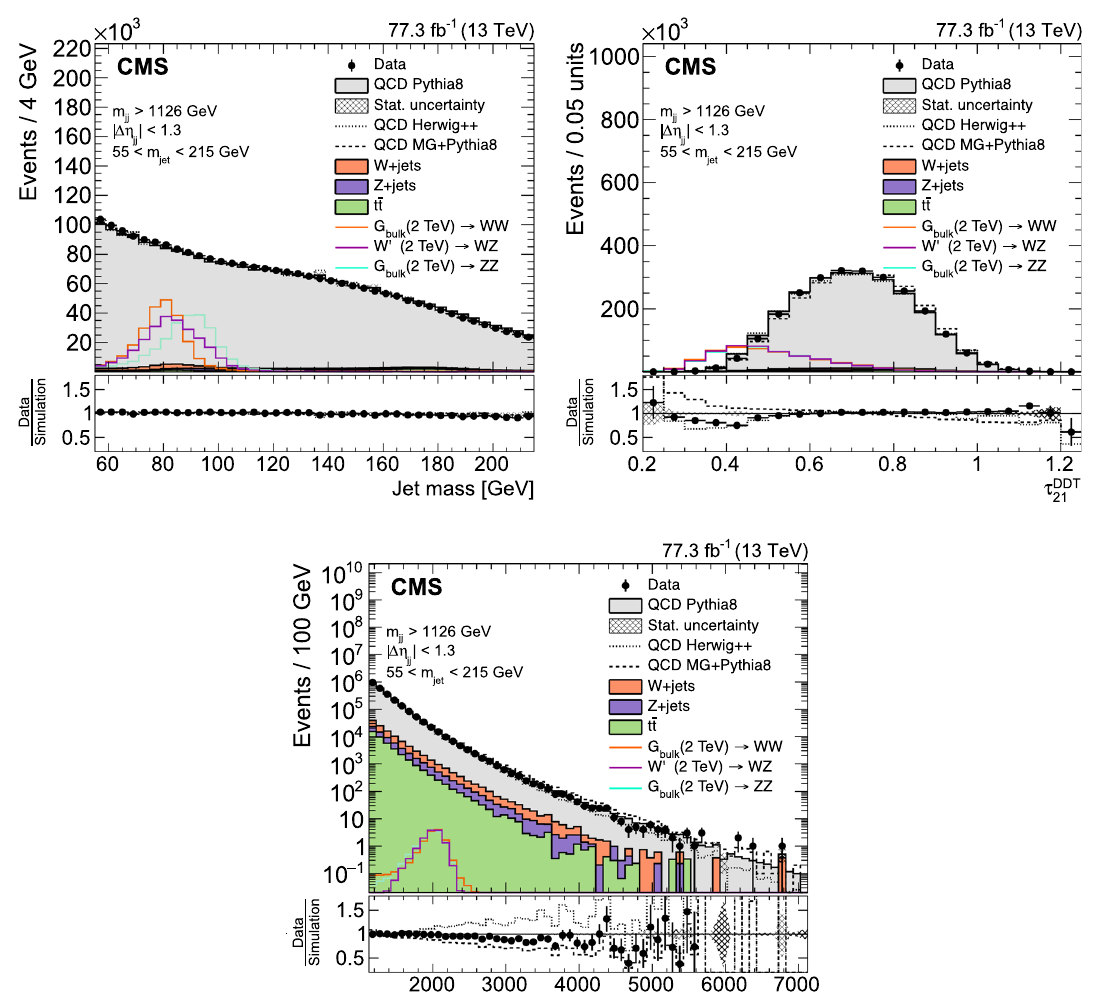
Fig. 4 Jet mass (upper left) and τ DDT scaled to their SM expectation as described in the text. The different (upper right) distributions for 21 signal distributions are scaled to be visible. No selection on τ DDT selected jets (one random jet per event), and dijet invariant mass distri- bution (lower), for events with a jet mass between 55 and 215GeV. For applied. The ratio plots show the fraction of data over QCD multijet the QCD multijet simulation, several alternative predictions are shown, simulation for pythia 8 (black markers), herwig ++ (dotted line), and MadGraph + pythia 8 (dashed scaled to the data minus the other background processes, which are